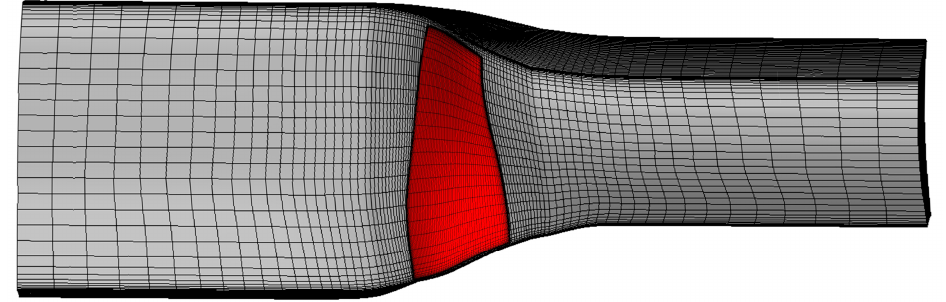
Figure 11. Mesh overview of the fluid calculation domain.